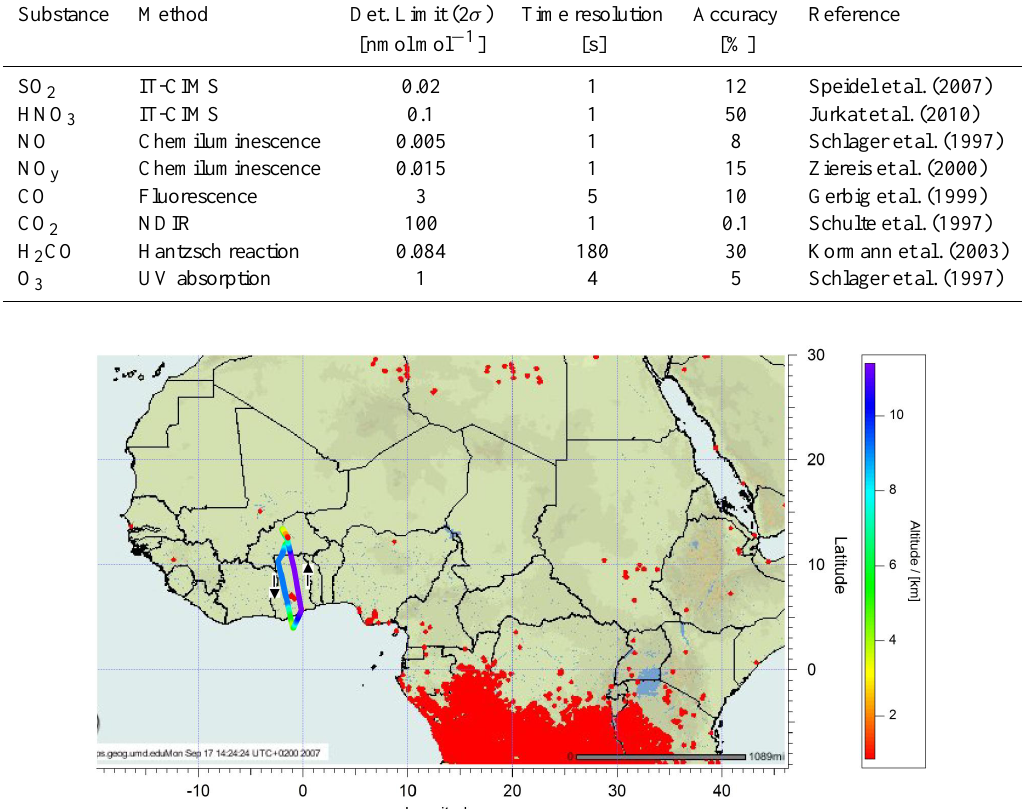
Fig. 1. Fires in Central Africa detected by MODIS (see text) for Northern Africa between the 1st and the 10th of August 2006. Also shown is the flightpath of the DLR research aircraft Falcon, color coded with flight altitude.